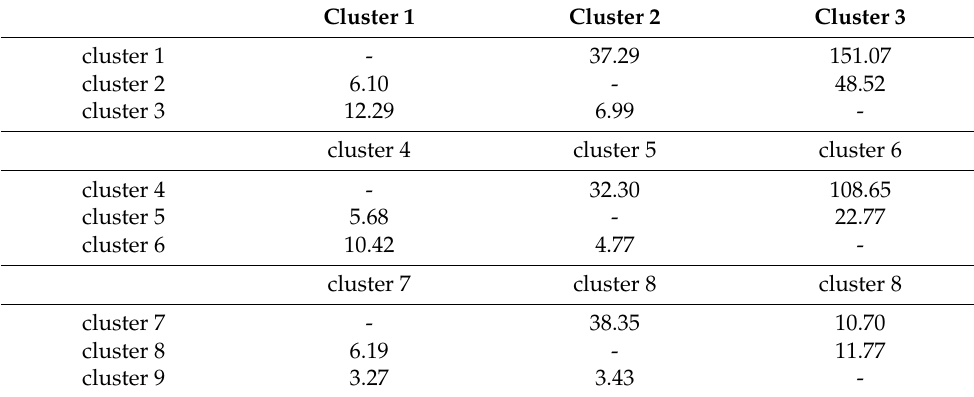
Table 3. Euclidean distancesof distinguished clusters.